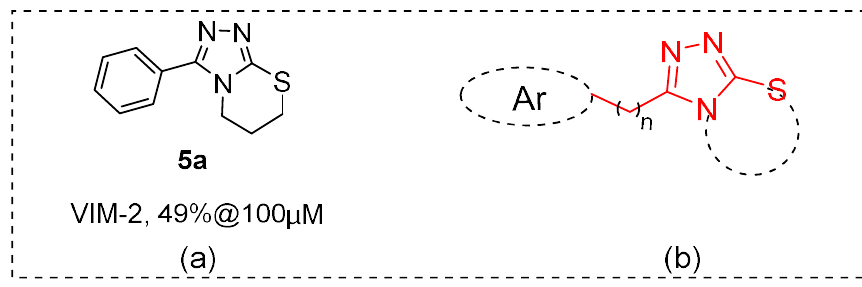
Figure 2. ( a ) Structure of compound 5a . ( b ) Schematic showing subgroups or atoms that were the focus of structural